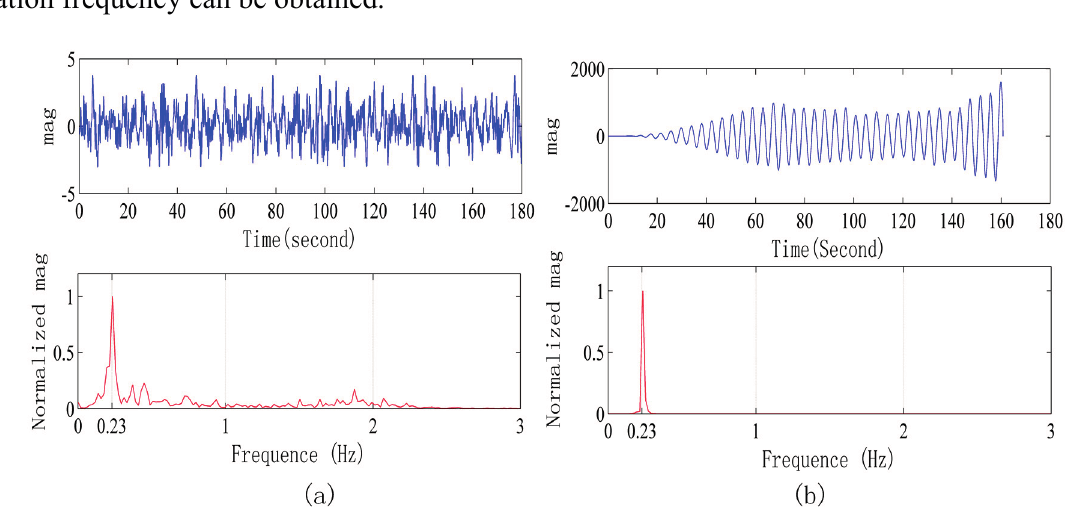
Figure 11. Signals waveform collected in a strong interference environment when the radar is 5 m away from human body. ( a ) Original signal waveform and its frequency spectrum; ( b ) Signal waveform after processing and its power